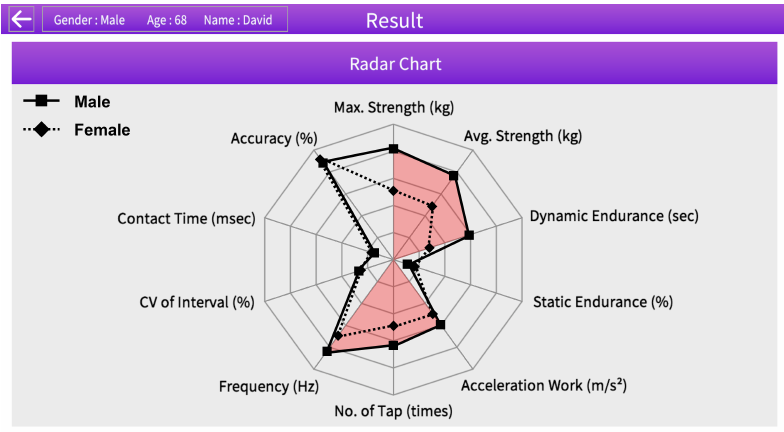
Figure 7. Radar Chart showing finger tapping